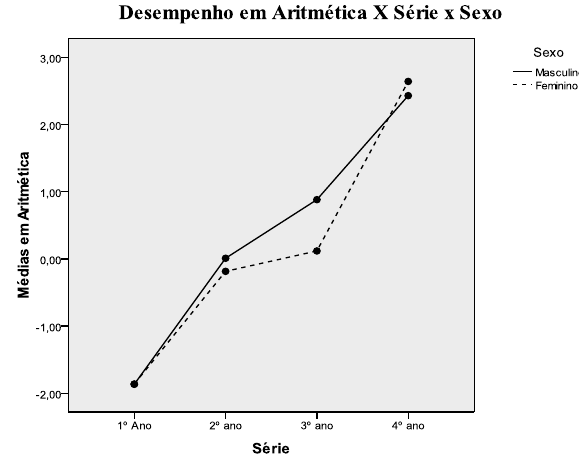
Figura 2 . Representação grá fi ca da análise de variância